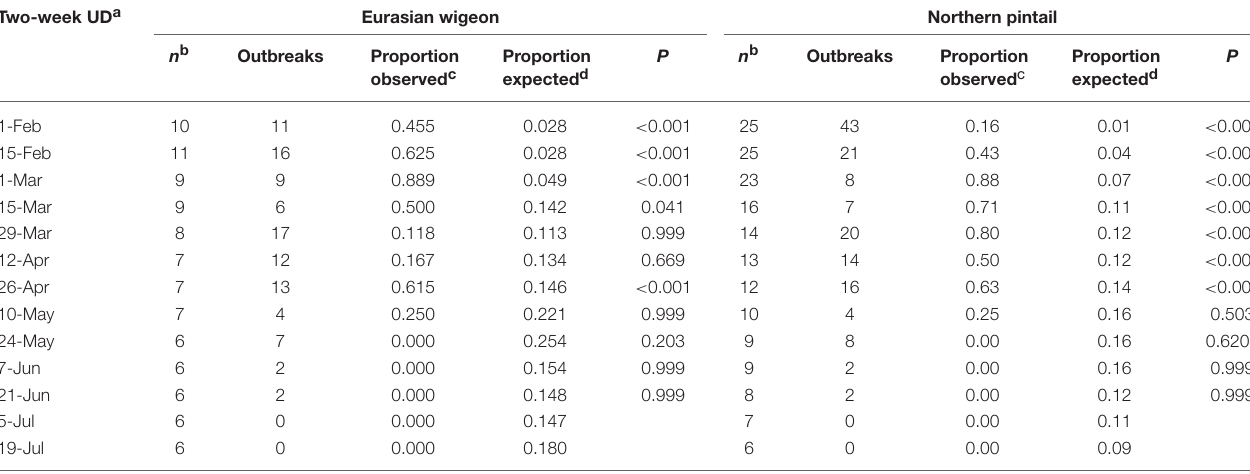
TABLE 2 | Observed and expected spatio-temporal association between H5N1 outbreaks and the utilization distributions of Eurasian wigeon and northern pintail during spring migration from wintering grounds in Hong Kong. Two-week UD a Eurasian wigeon Northern pintail n b Outbreaks Proportion observed